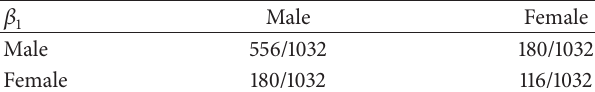
Table 6: Gender bivariate 𝛽 1